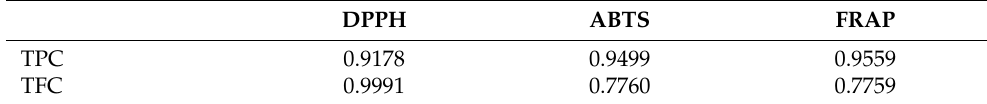
Table 5. Correlation coefficients between the content of TPC and TFC with DPPH, ABTS and FRAP. DPPH ABTS FRAP TPC 0.9178 0.9499 0.9559 TFC 0.9991 0.7760